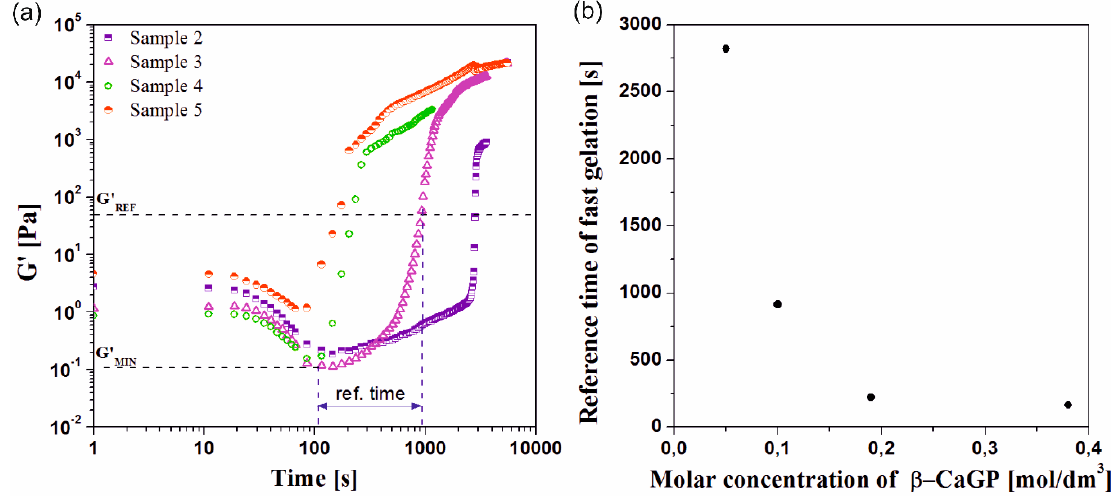
Figure 5. Kinetics of changes in the value of storage modulus G’ along with the presentation of a method for determining the reference time of rapid gelation ( a ) and the dependence of the reference time of gelation on molar concentration of calcium- β -glycerophosphate ( b ).